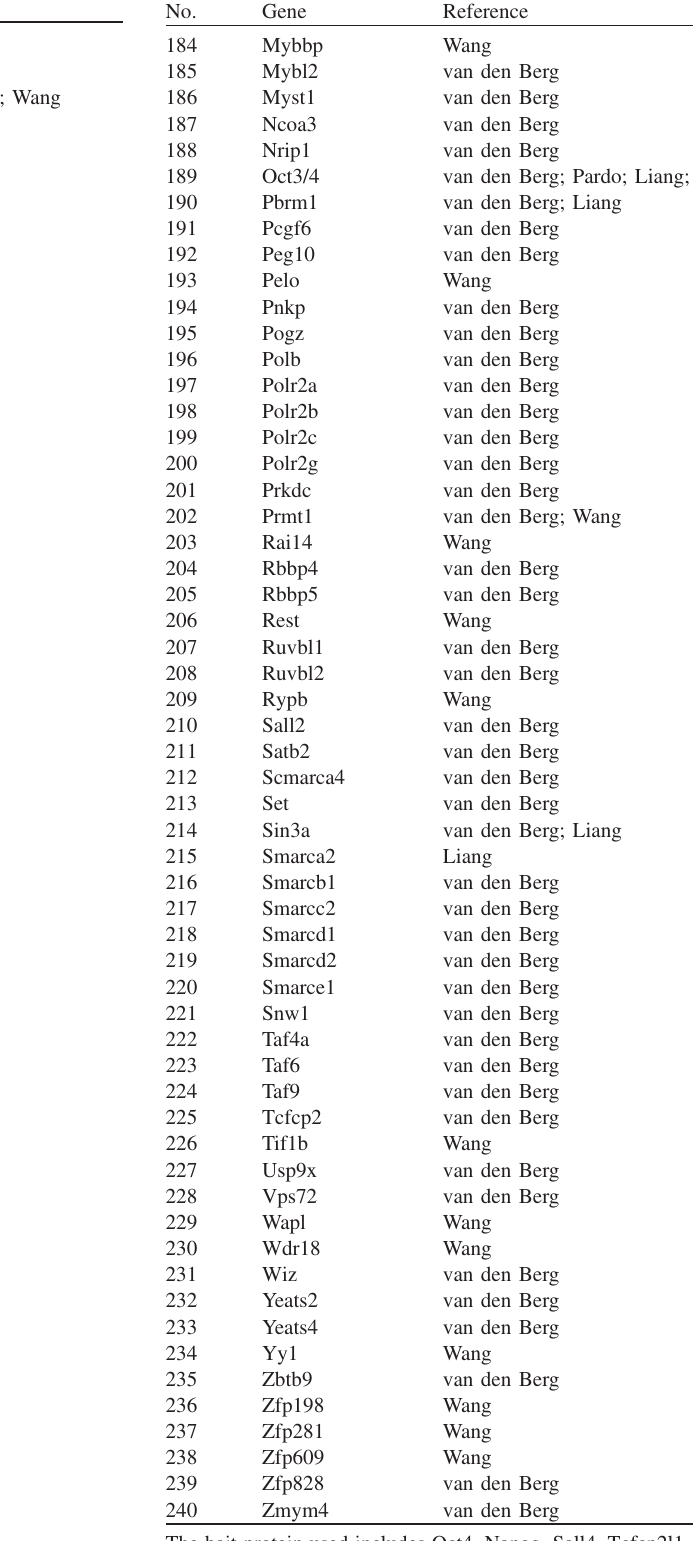
The bait protein used includes Oct4, Nanog, Sall4, Tcfcp2l1, Dax1, Esrrb, Rex1, Nac1 and Zfp281. Proteins found when Oct4 was the bait are shaded grey. *Nanog and *Zfp42 (Rex1) interacts with Oct4 when they are used as the